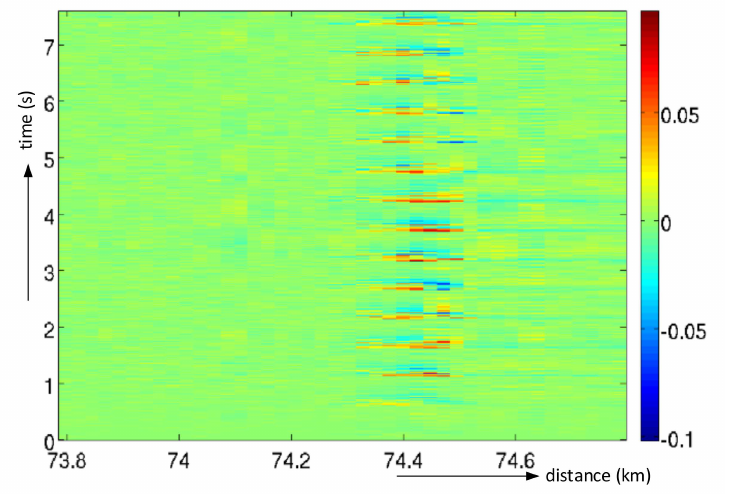
Figure 18. An example of a “waterfall” with a detected event after filtering. The corresponding time-domain course of the signal (hammer strokes) from the single point in the fiber is shown in Figure